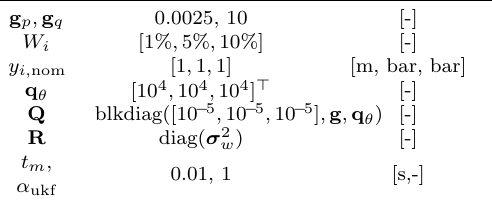
Table 3: Noise and estimator parameters.